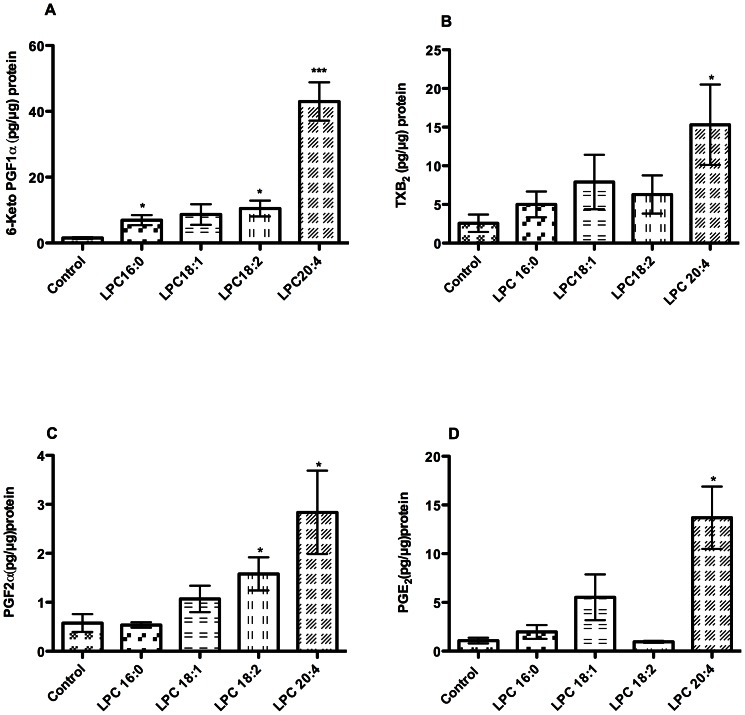
Prostanoid release from LPC-treated aortic rings.The rings were incubated in 200 µl aerated PSS under cell culture conditions at 37°C for 1 h. Thereafter, buffer was replaced with fresh PSS supplemented with PSS (control) or 10 µM LPC followed by further incubation under cell culture conditions at 37°C for 1 h. (A) 6-keto PGF1α, a stable degradation product of PGI2 (B), TXB2, a stable degradation product of TXA2, (C) PGE2 and (D) PGF2α were quantified by EIA assays and rings were solubilized for protein quantification. Results shown in A and B are means ± SD of four experiments and those in C and D of three experiments, done in triplicates. *P<0.05, **P<0.01***P<0.001.